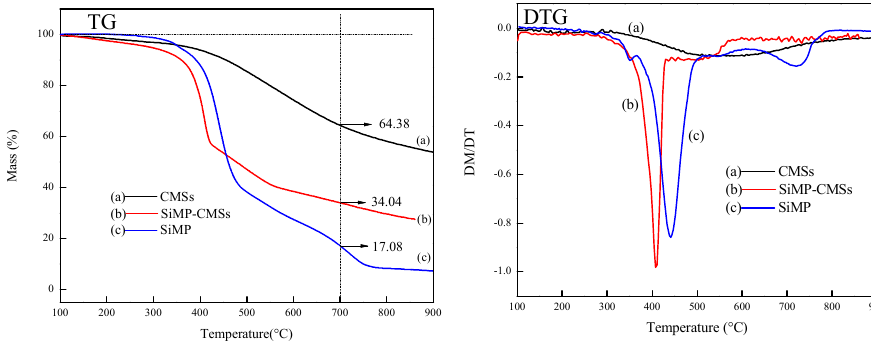
Figure 5. TG and DTG curves of CMSs ( a ), SiMP-CMSs ( b ), and SiMP ( c ).